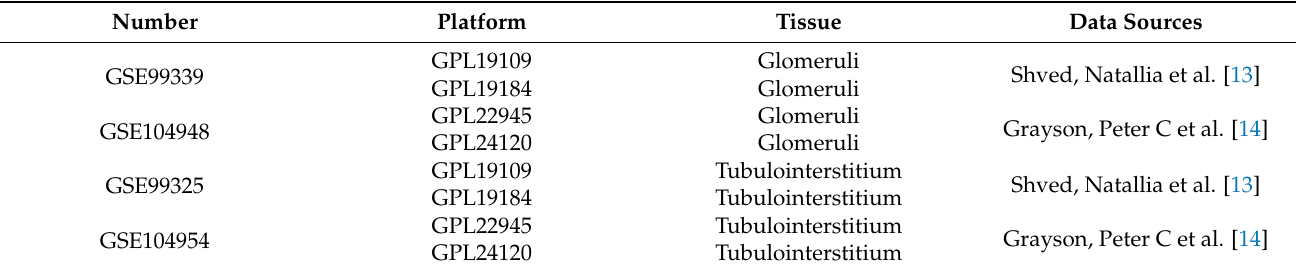
Table 1. The information of the datasets used for